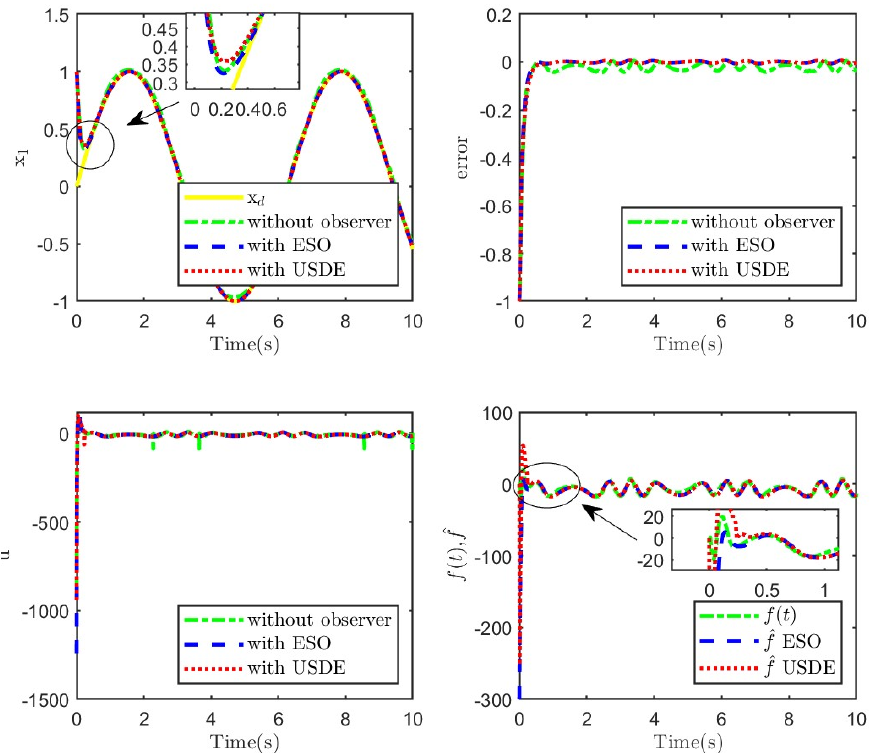
Figure 8. Tracking results of the system with matched uncertainty under the sinusoidal signal.